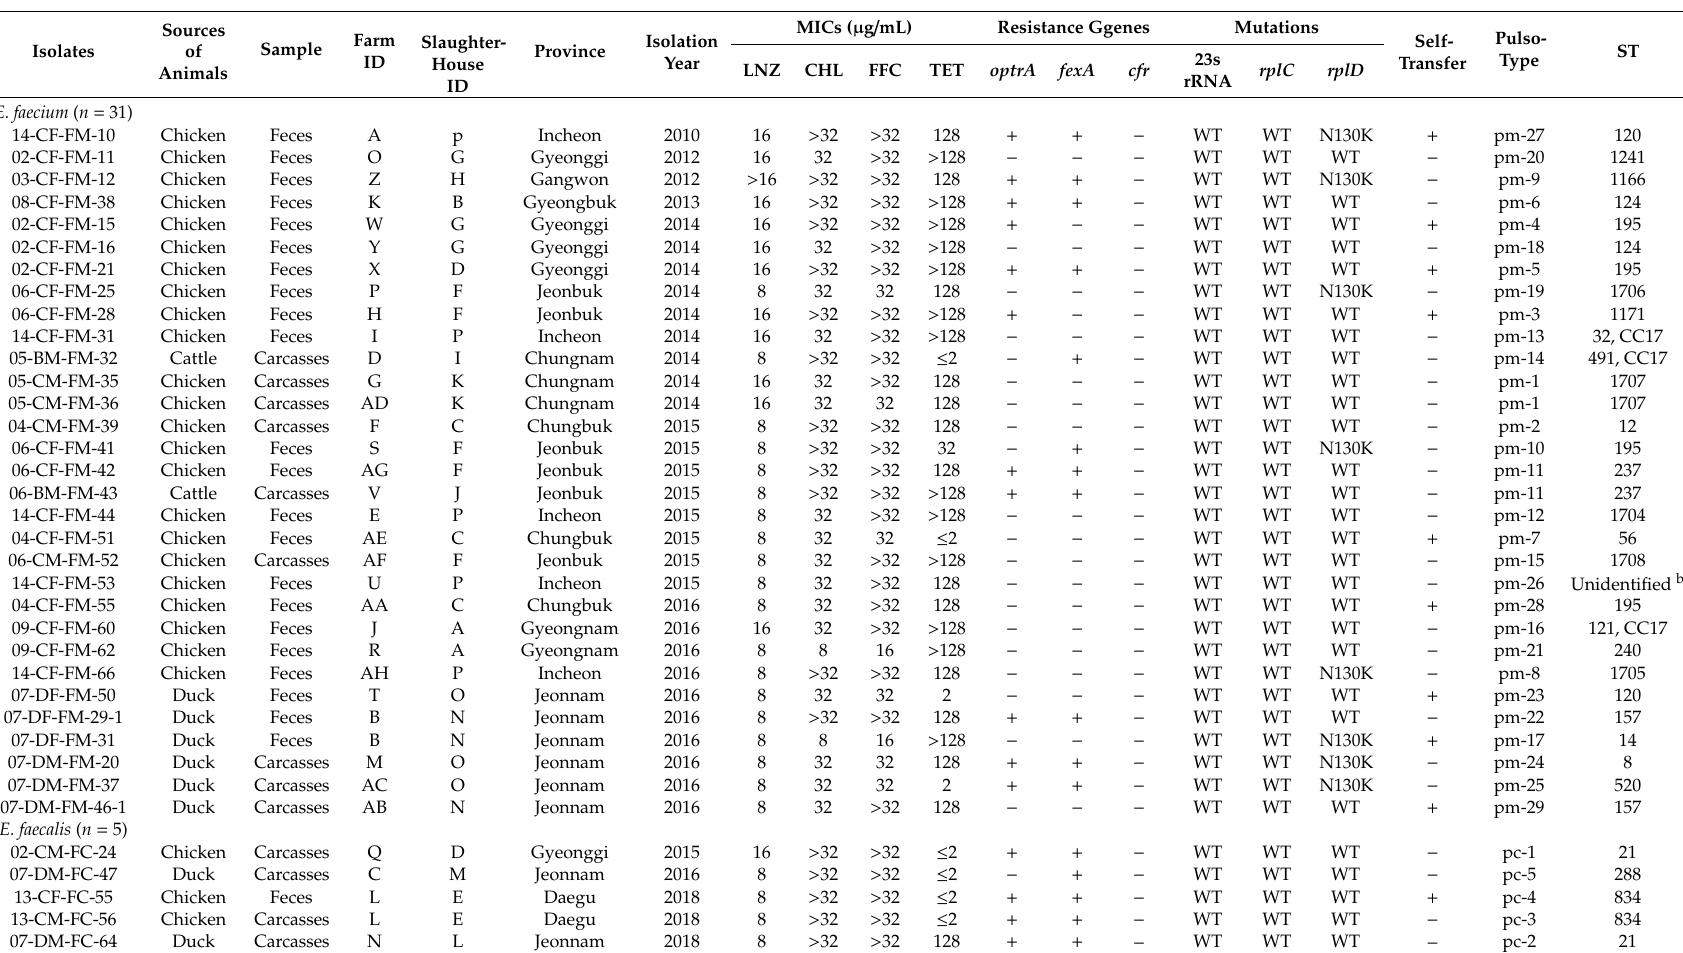
Table 2. Characteristics of poxtA -carrying Enterococcus faecium and E. faecalis isolated from food-producing animals during 2008–2018 in South Korea a .